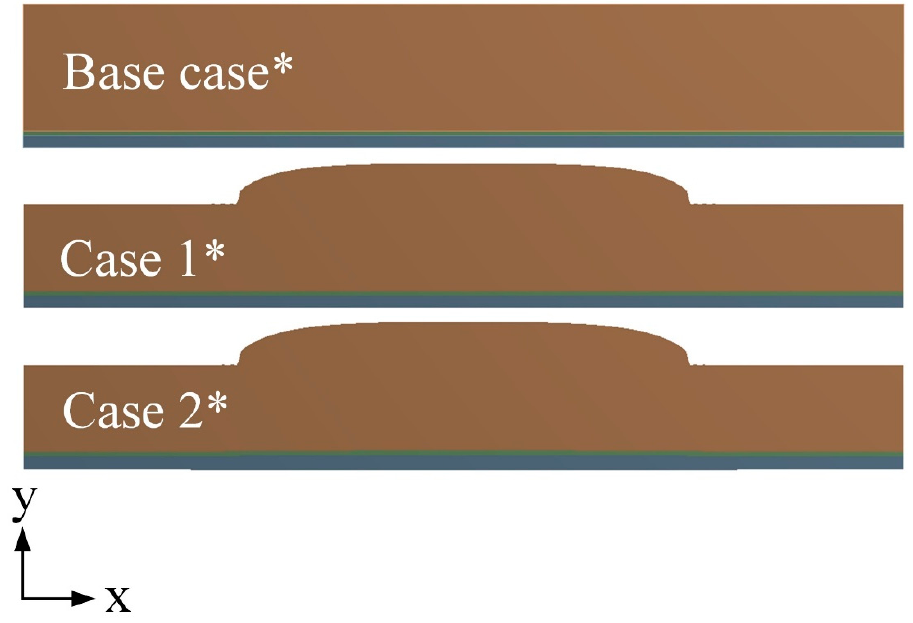
Figure 4. Deformations of the MEA in the Base case*, Case 1* and Case 2*.